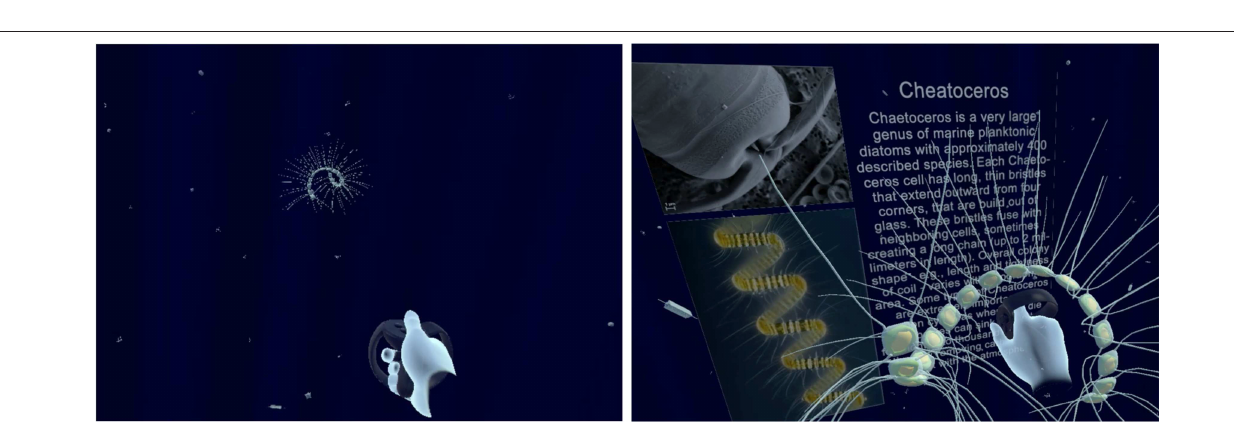
FIGURE 6 | Five different plankton types and morphologies were rendered in the application, providing users with a novel way to collect and learn about these different types. (Left) A user’s view inside the Oculus Rift head-mounted display while capturing a floating phytoplankton. (Right) A user’s view inside the Oculus Rift head-mounted display while holding a “3D Chaetoceros” in the Plankton Zoo VR